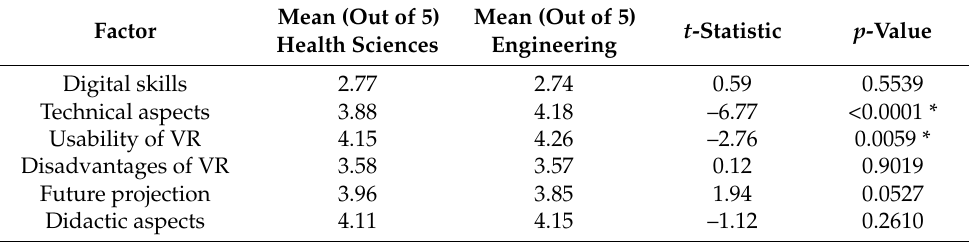
Table 2. Mean values and bilateral t-test statistics for independent samples with Welch’s correction, without assuming equality of variances, differentiating by areas of